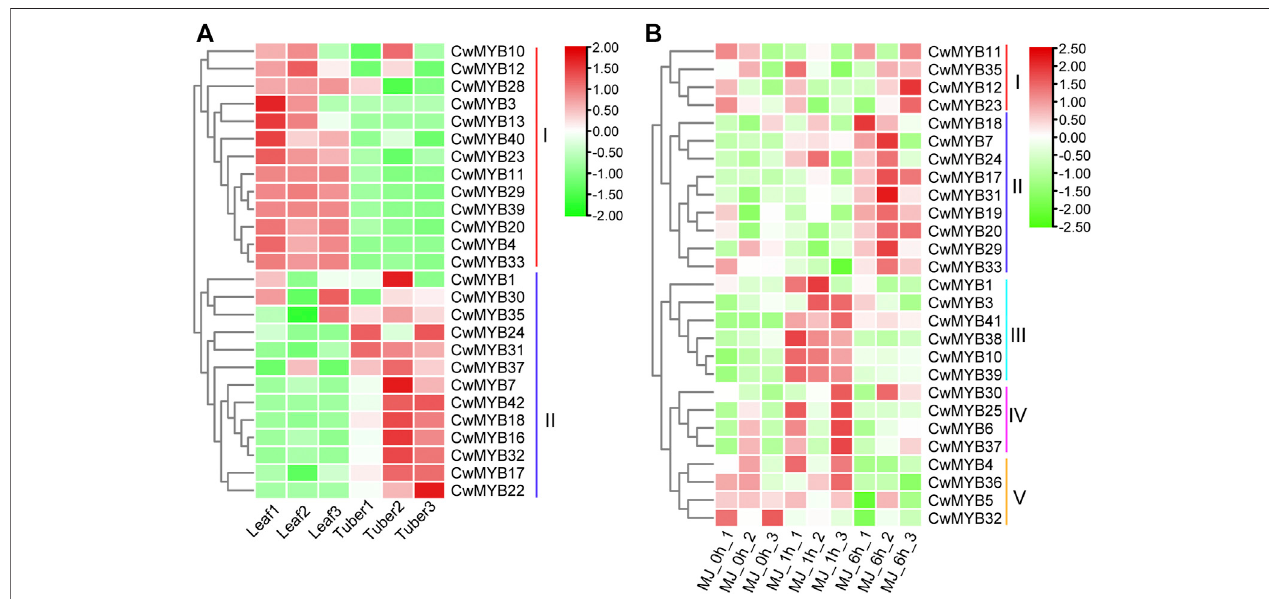
FIGURE 6 | Expression pro fi les analysis of R2R3 - CwMYB genes (A) R2R3-CwMYB gene expression patterns in tuber and leaf of C. wenyujin . (B) R2R3 - CwMYB gene expression patterns in C. wenyujin with MeJA induction. Heatmap was created by TB tool using the transcript per million (TPM) values. The red and green cells represent the highest and lowest expression levels,